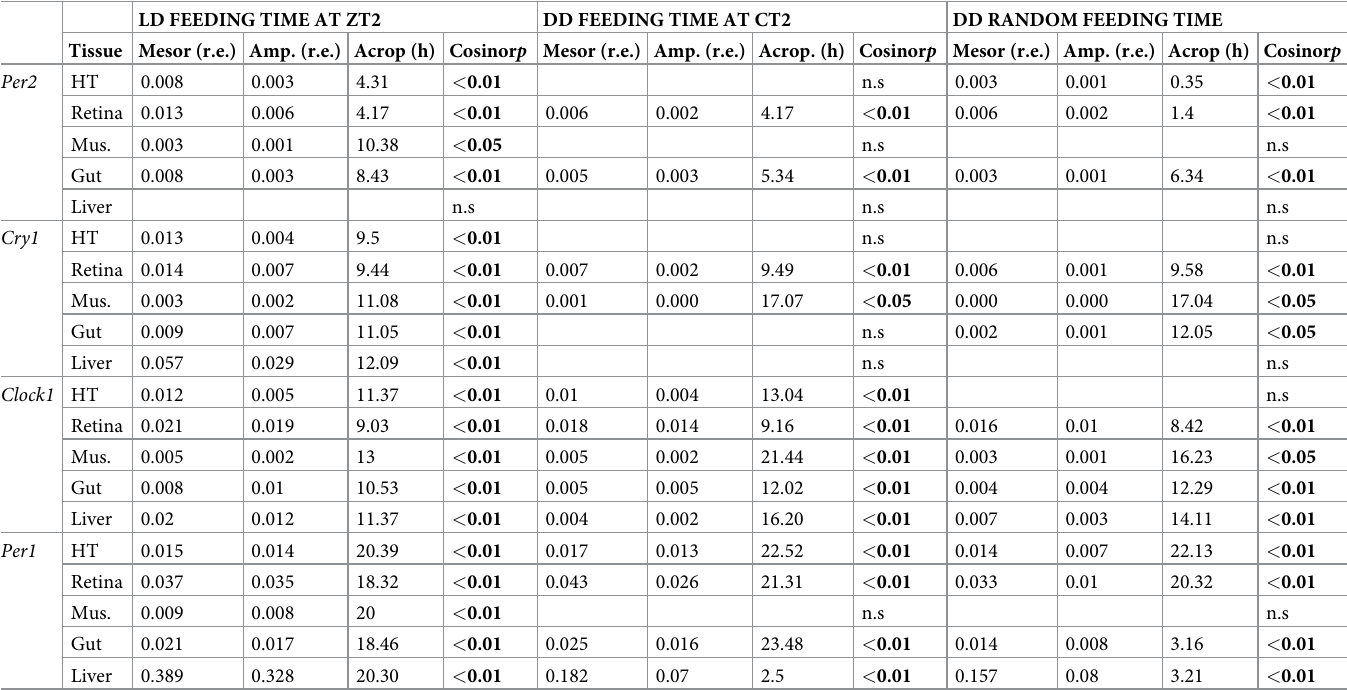
Table 1. Rhythmic parameters of clock gene expression. LD FEEDING TIME AT ZT2 DD FEEDING TIME AT CT2 DD RANDOM FEEDING